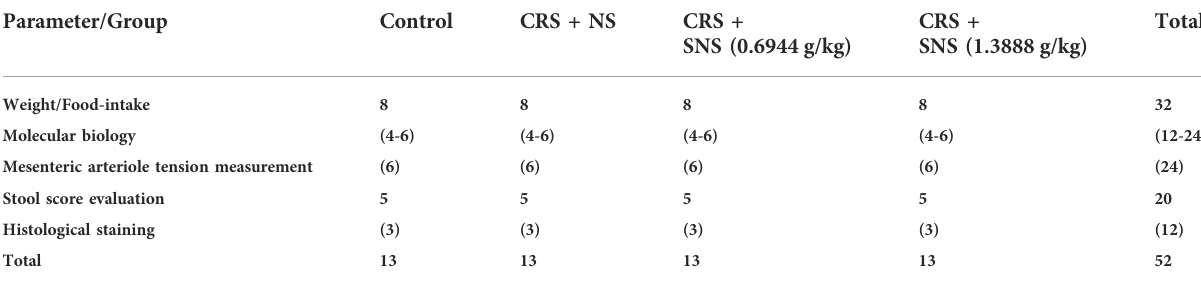
TABLE 1 Number of rats in each group and used in each parameter.